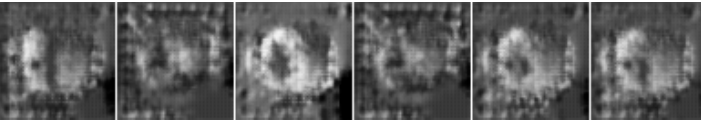
Figure 11. Noise pattern in the generated images.